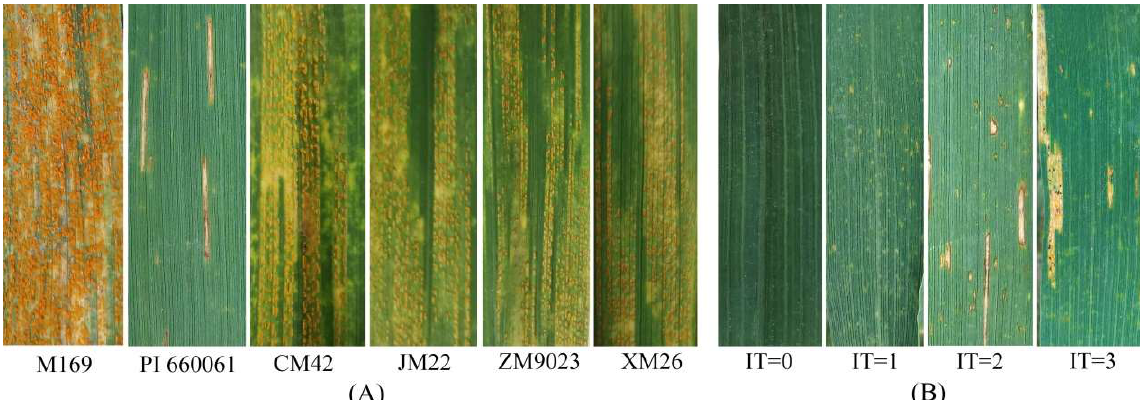
Figure 2. Adult-plant stripe rust reactions on leaves of five parents and susceptible control M169 ( A ); phenotype of sixteen final selected posterities, IT = 0 (including BC 2 F 6 -73), IT = 1 (including BC 2 F 6 -21, BC 2 F 6 -86, BC 2 F 6 -97), IT = 2 (including BC 2 F 6 -28, BC 2 F 6 -48, BC 2 F 6 -59, BC 2 F 6 -65, BC 2 F 6 -84, BC 2 F 6 -85, BC 2 F 6 -106, BC 2 F 6 -107), IT = 3 (including BC 2 F 6 -33, BC 2 F 6 -40, BC 2 F 6 -61, BC 2 F 6 -96) ( B